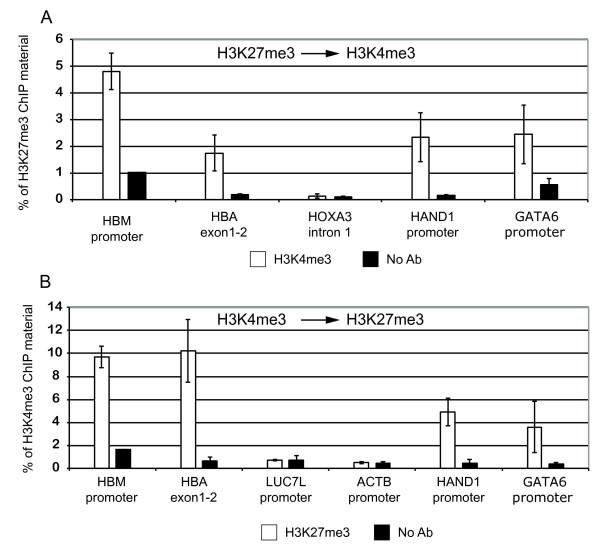
Chromatin immunoprecipitation quantitative PCR (ChIP-qPCR) characterisation of the α globin chromatin bivalency. (a) Sequential ChIP with H3K27me3 followed by H3K4me3 antibody. HOXA3 intron represents an H3K27me3 genomic region; HAND1 and GATA6 promoters are control bivalent promoters. (b) Sequential ChIP with H3K4me3 followed by H3K27me3 antibody. LUC7L and ACTB promoter are H3K4me3 modified promoters. The error bars show the standard deviation of three independent ChIP-qPCR experiments.